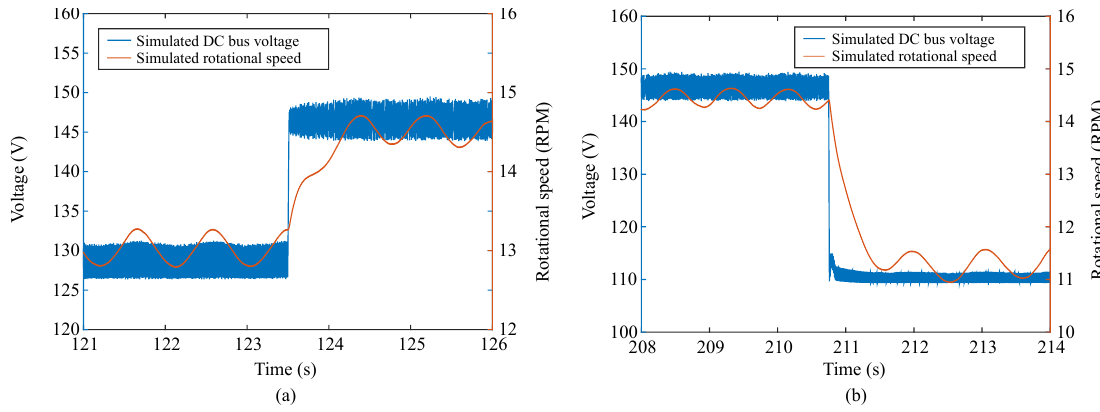
Figure 11. Simulated DC voltage and turbine rotational speed during ( a ) step one and ( b ) step two.